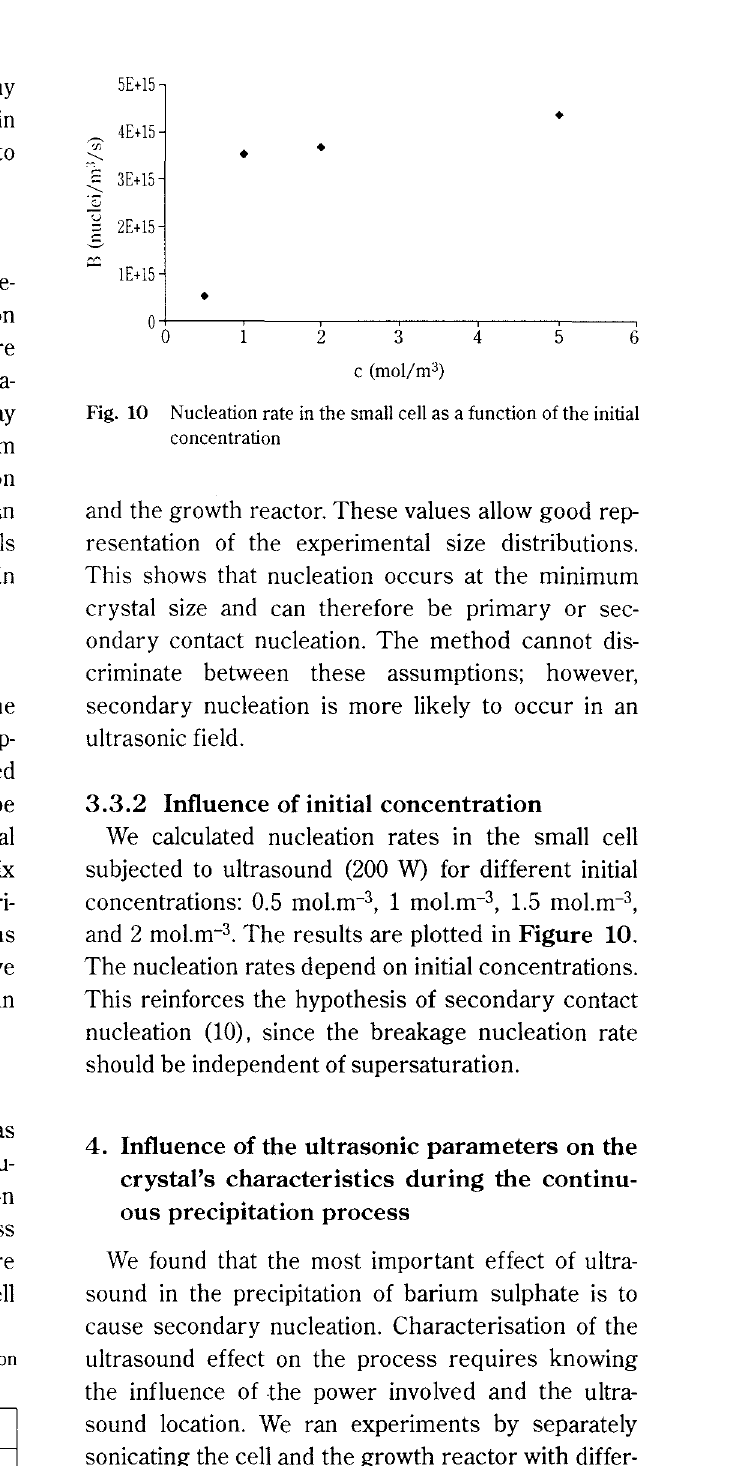
Table 4 Nucleation rate values in the growth reactor calculated by population balance, crystals/m3/s Growth reactor Growth reactor without ultrasound